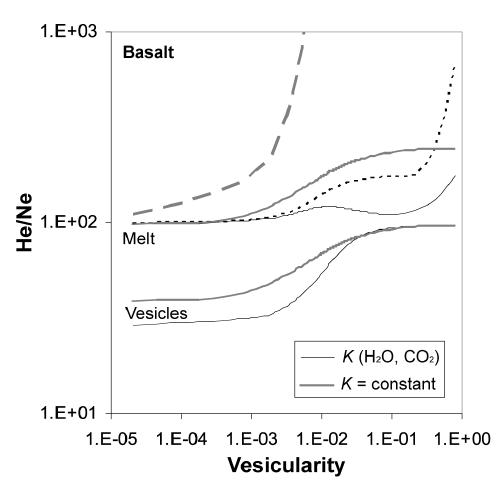
Fig. 15. He/Ne fractionation during closed system degassing of basaltic melt at 1200°C. Curves and conditions as in fig. 13. The behavior is qualitatively similar to that discussed in the case of argon, al- though the fractionation is more